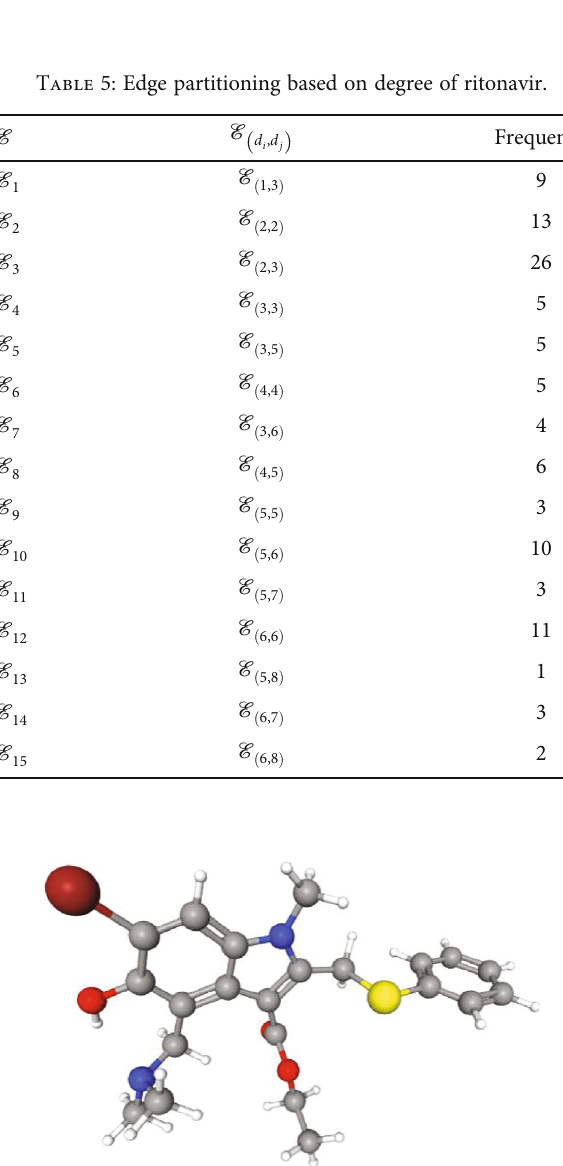
Figure 10: Molecular graph of ritonavir.